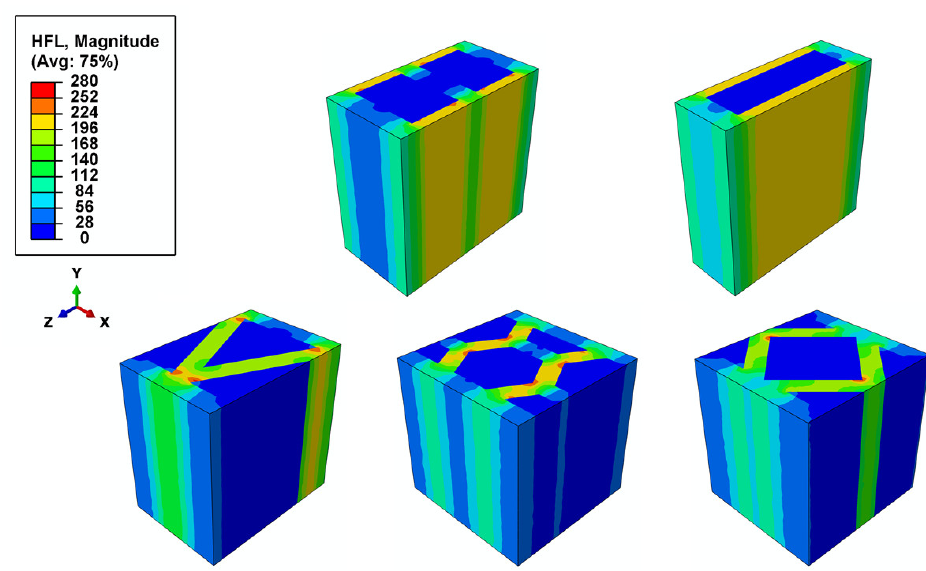
Figure 7. Heat flux within the 3DPC walls for the various infill shapes.